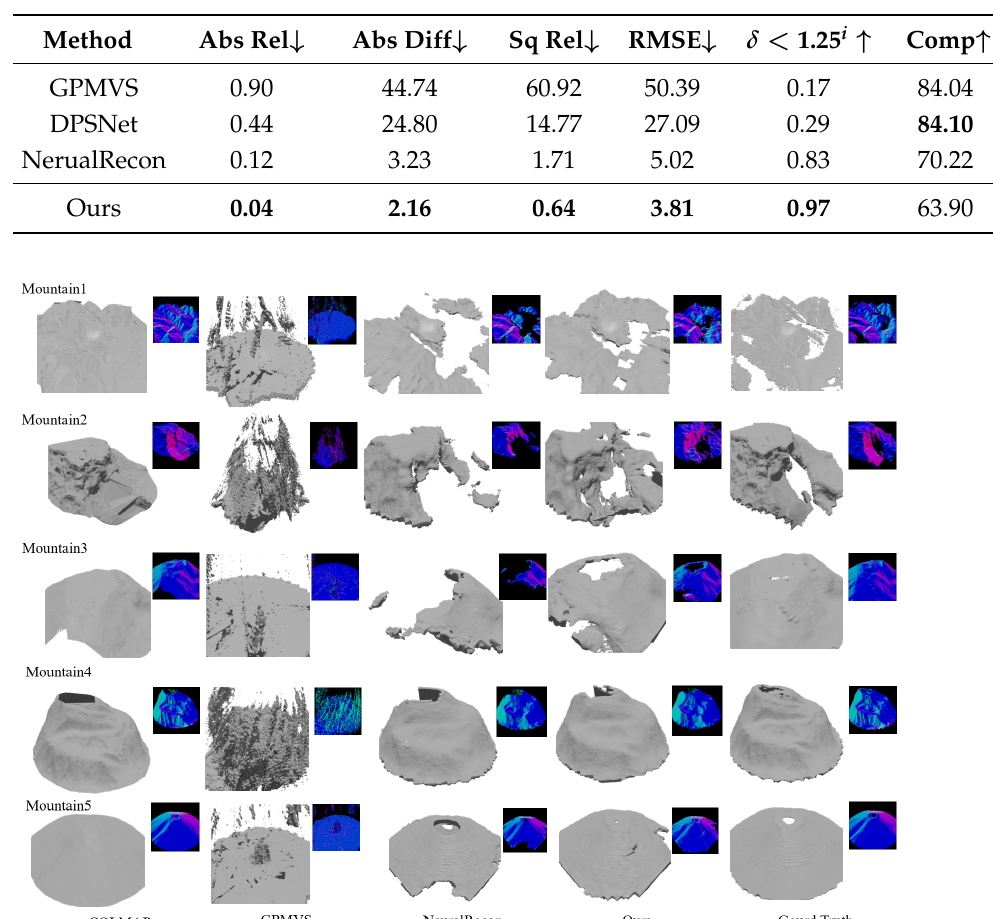
Table 4. Depth estimation accuracy of different methods. We use the same method in NeuralRe- con [13] to calculate the metric values.